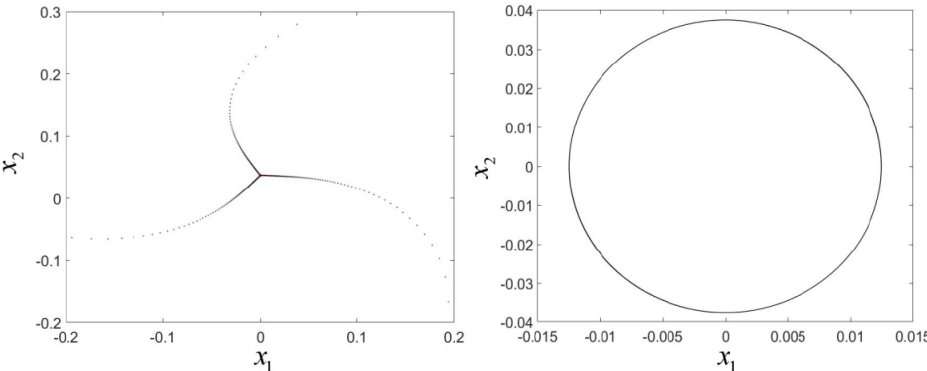
μ − : ( left ) the stable fixed point;